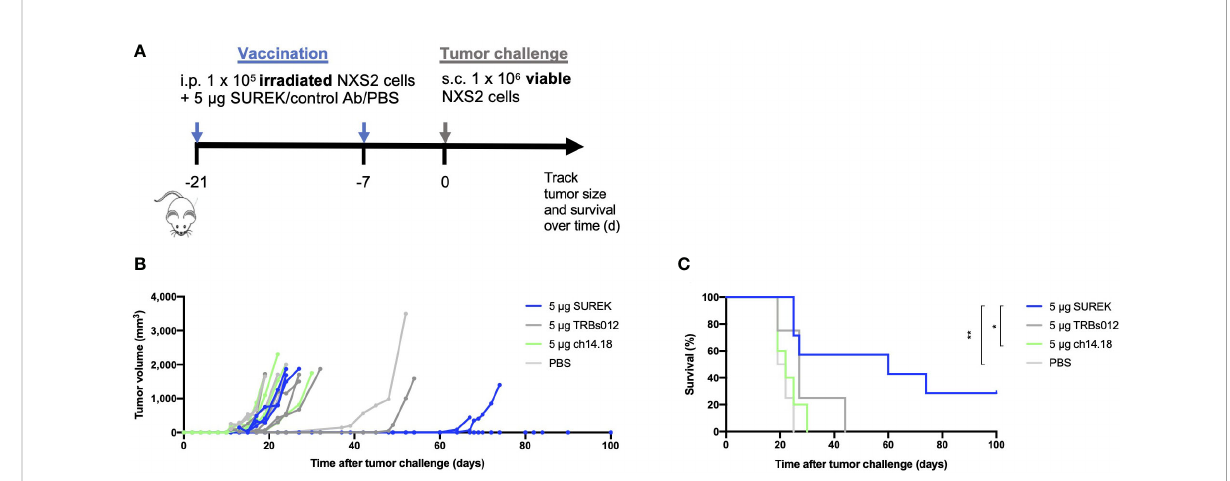
FIGURE 2 Tumor cell vaccination in combination with SUREK treatment enhances overall and tumor-free survival with aggressive syngeneic neuroblastoma transplants (A) Schematic representation of treatment and analysis. At day 21 and 7 before tumor challenge, A/J mice were vaccinated with intraperitoneal injections (i.p.) of 1 x 10 5 irradiated NXS2 cells followed by i.p. injection of 5 µg of SUREK (n=7) or the control antibodies ch14.18 (n=5), TRBs012 (n=5) or PBS (n=4). On day 0, all mice were challenged with a subcutaneous injection of 1 x 10 6 viable NXS2 cells. (B) Tumor size was checked every other day via calipermetry. (C) Survival of mice is shown in a Kaplan-Meier-Curve. Statistical analysis was done using log-rank test to compare different groups: *p<0.05;